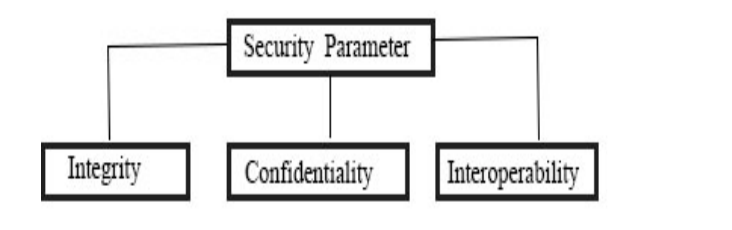
Figure 3. Selected security parameters . Table 2. Tag distribution and classification factors .